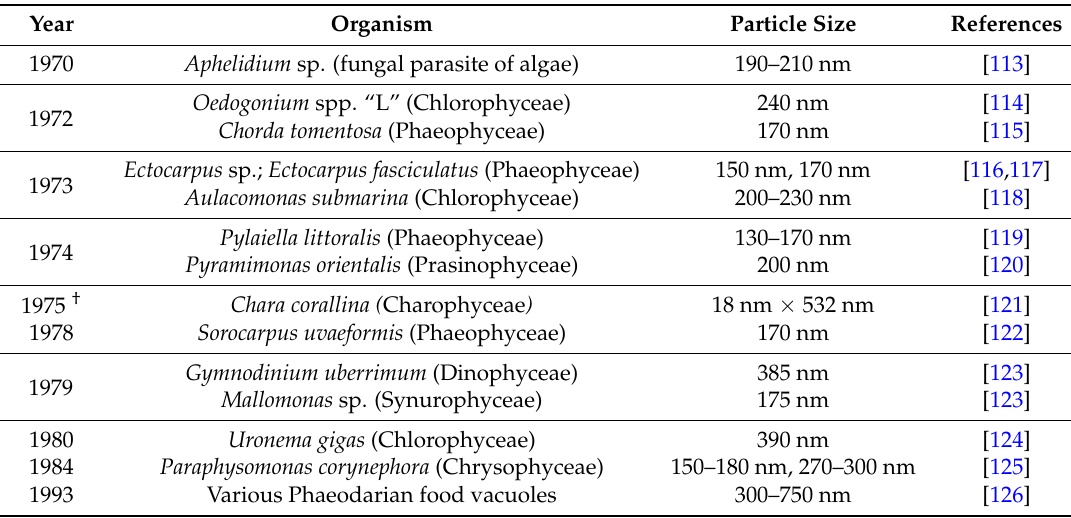
Table 3. A chronological list of organisms shown in the literature to contain viruses consistent with the giant virus size